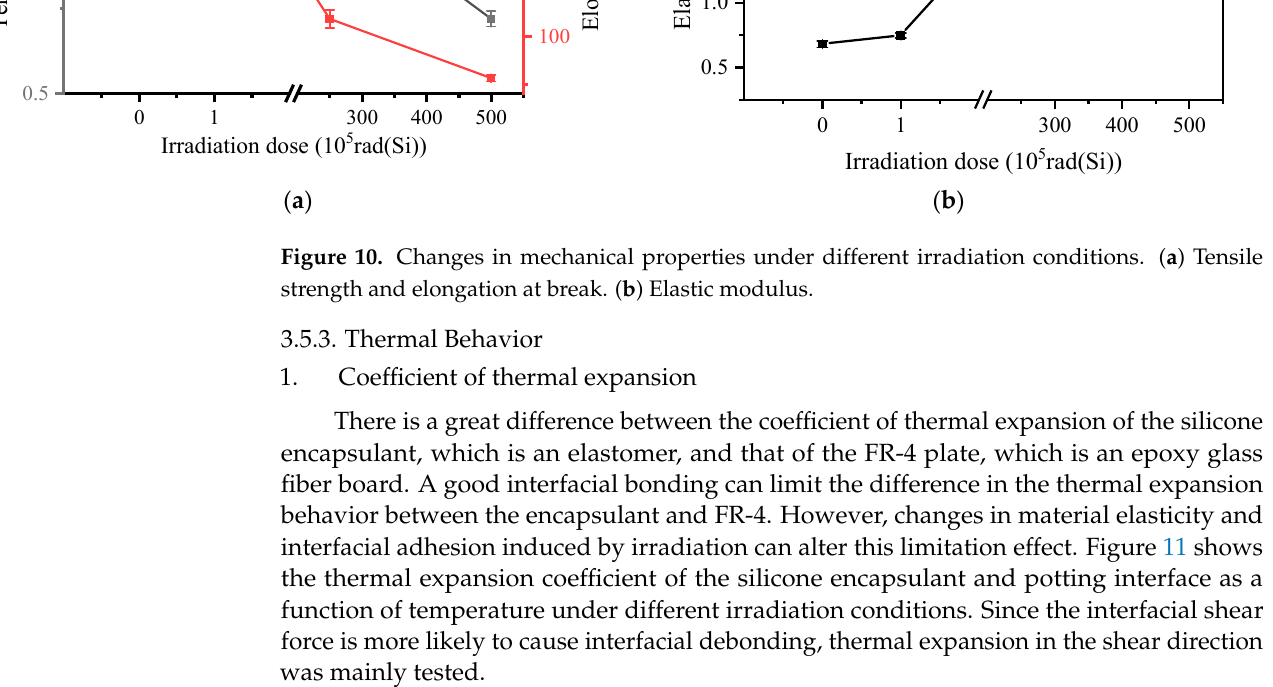
Figure 10. Changes in mechanical properties under different irradiation conditions. ( a ) Tensile strength and elongation at break. ( b ) Elastic modulus.